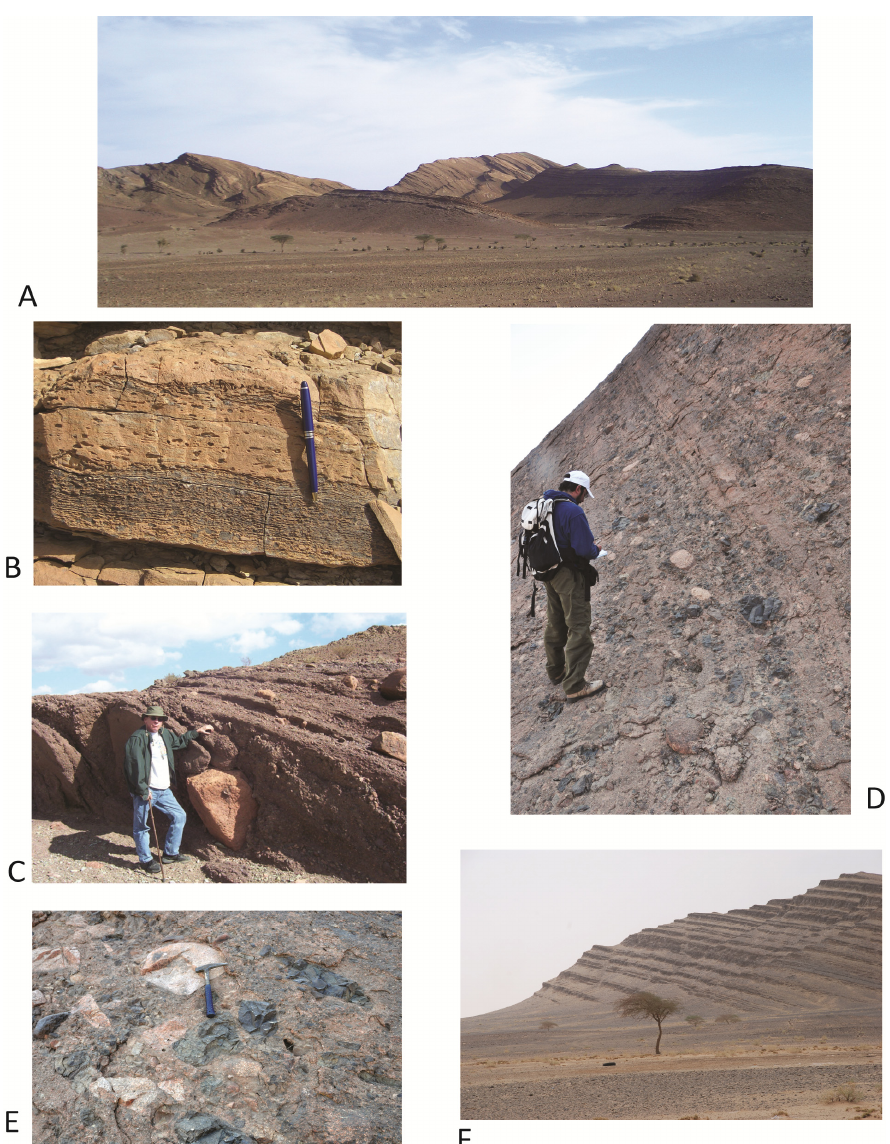
Figure 21. Lithologic and bedding features of the Jibalah group. ( A ) Well-bedded limestone, Dhaiqa formation, Dhaiqa basin; ( B ) Detail showing microbial laminites, Dhaiqa formation, Dhaiqa basin; ( C ) Paraconglomerate at the base of the Dhaiqa formation, Dhaiqa basin comprising granite boulders embedded in coarse-grained pebbly sandstone (R.J. Stern for scale); ( D ) View of massive conglomerate (to the left) overlain by well-bedded conglomerate and sandstone (to the right), basal part of the Jifn basin (R. Trindade for scale); ( E ) Rounded-to-subangular pebble-to-boulder clasts of granite and mafic volcanic rock, Jifn basin; ( F ) Cyclic bedding in the eastern Antaq basin composed of arkosic sandstone and siltstone, subordinate conglomerate, and minor